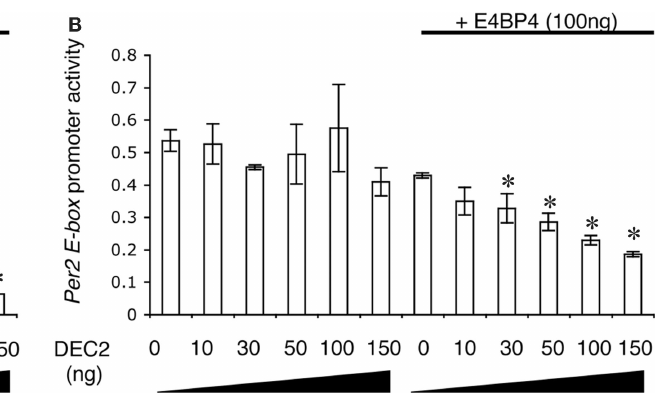
FIGURE 3 | DEC2 represses Per2 EE element promoter activity . (A,B) E4BP4–DEC2 heterodimer represses Per2 EE element promoter activity. NIH3T3 cells were transfected with different amounts of E4bp4 /pcDNA3.1 or Dec2/ pcDNA3.1 plasmid vector, 100ng Per2 EE element luciferase/pGL3 plasmid vector, 3ng of Bmal1 /pcDNA3.1 and Clock /pcDNA3.1, and 20ng pRL-TK plasmid vector. Per2 EE element promoter activity is presented as